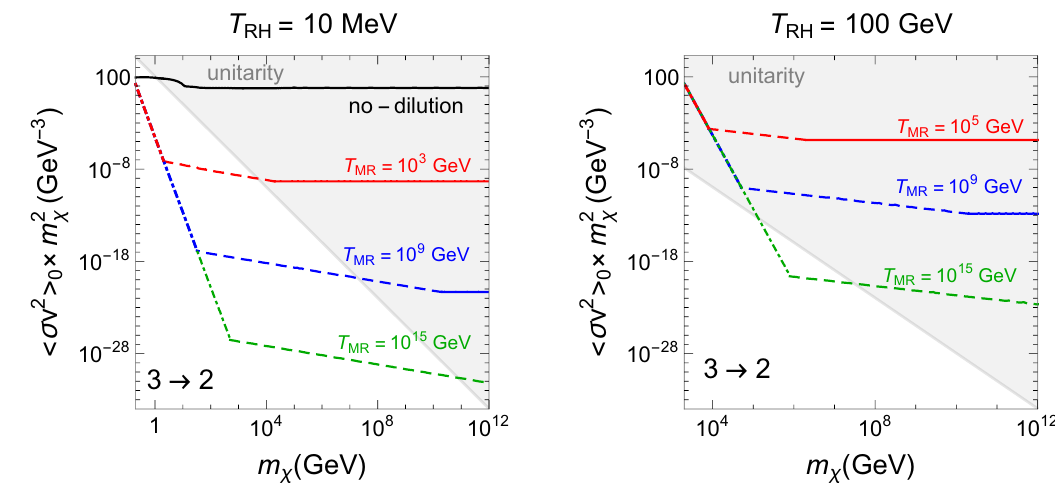
Figure 3 . Same as figure 2, for a scenario in which the dominant number-changing DM annihila- tions are of 3 → 2